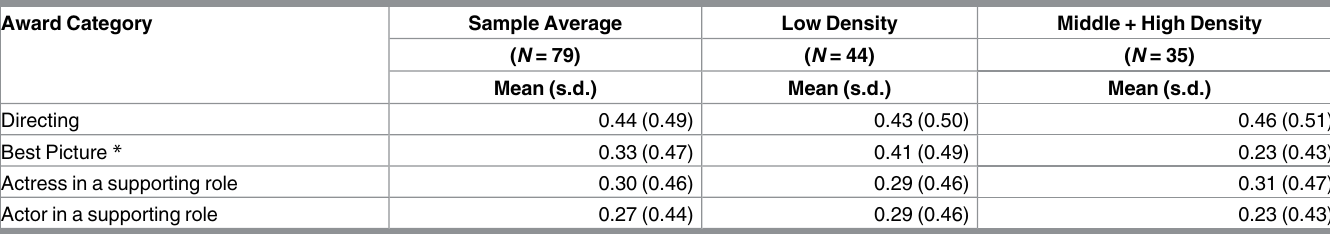
Table 4. Social networks and the correct prediction of film award